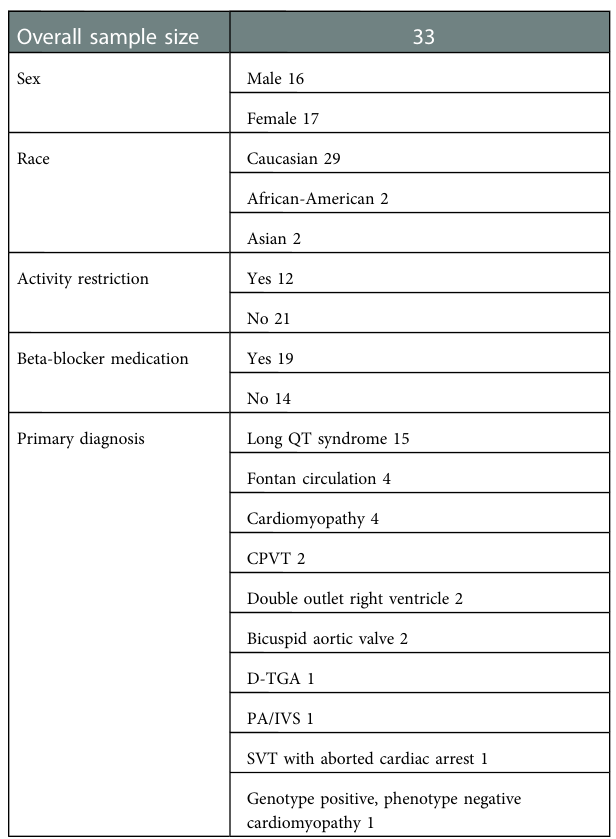
TABLE 1 Demographic data for the young cardiology patients with serial cardiopulmonary exercise tests in the 12 months before and after the COVID-19 lockdown.